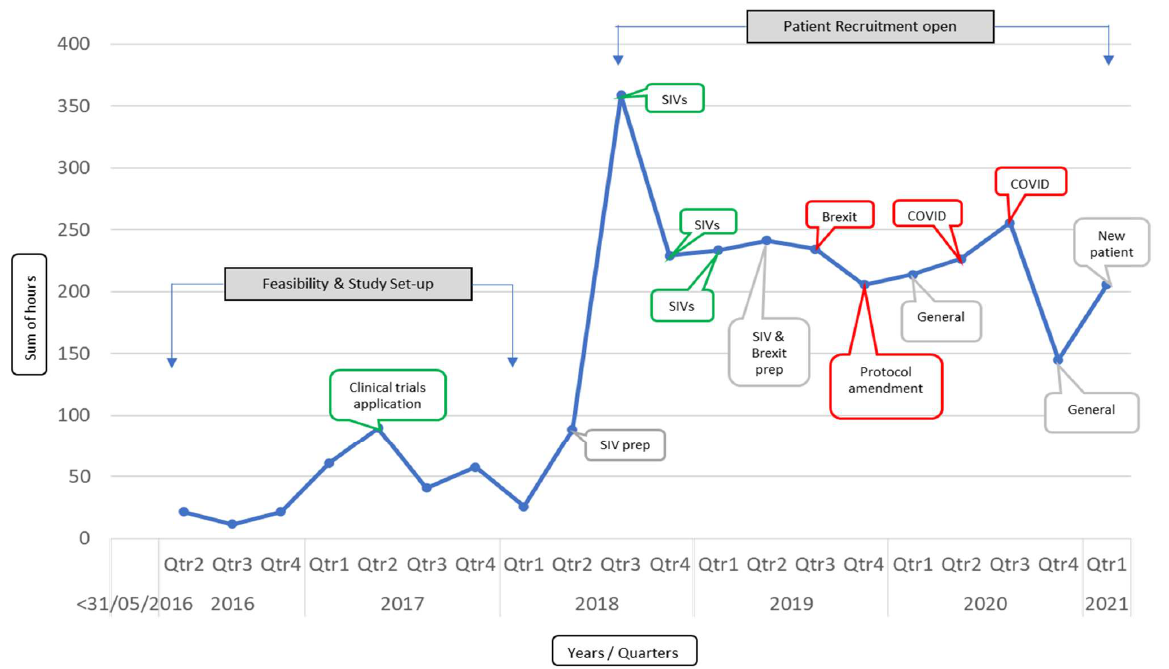
Figure 2. A representative CTRIAL-IE study before and during the pandemic, highlighting the effect of the pandemic (and Brexit) on level of staff resource hours for trial management (x-axis: staff hours, y-axis: years in quarters) Green and grey circled tasks: regular trial related work; red circled tasks: stressors resulting in increased work hours.